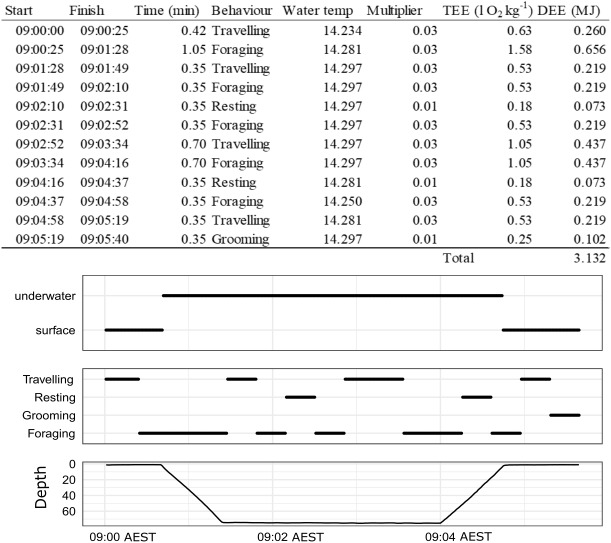
An example of how DEE is calculated for a single dive of a wild male juvenile Australian fur seal from Seal Rocks (winter), Victoria, Australia.Panels show location (underwater or surface), behaviour state (travelling, resting, grooming, foraging) and depth.